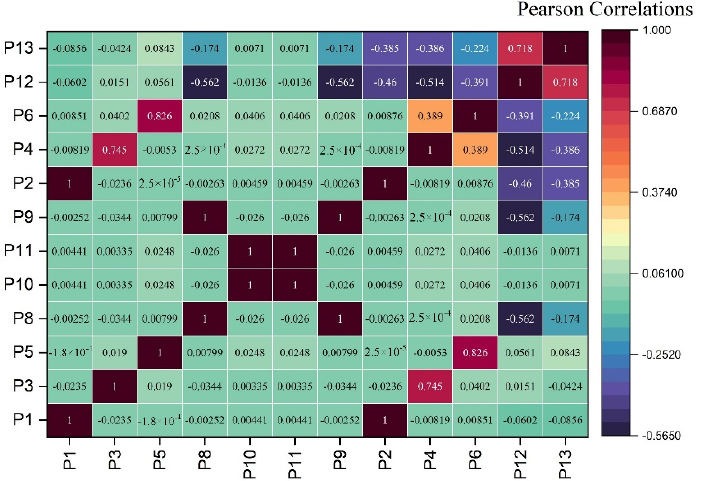
Figure 5. Parameter correlation chart.